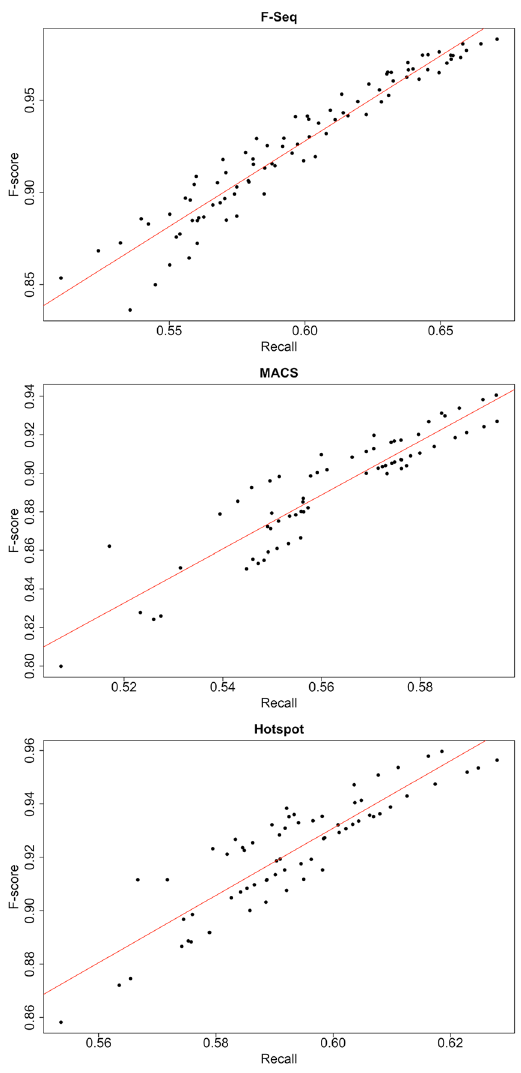
Figure 3. Linear Regression of F -scores and recall based on observations versus predictions. Linear regression 1 (red lines) of F -scores and recall – computed between observations and predictions – for each peak caller 1 proves their linear relationship (adjusted R squared of 0.92, 0.84 and 0.79, respectively). Each dot represents a tuple of FDR (or z-score in case of F-Seq) cutoff, cell line and